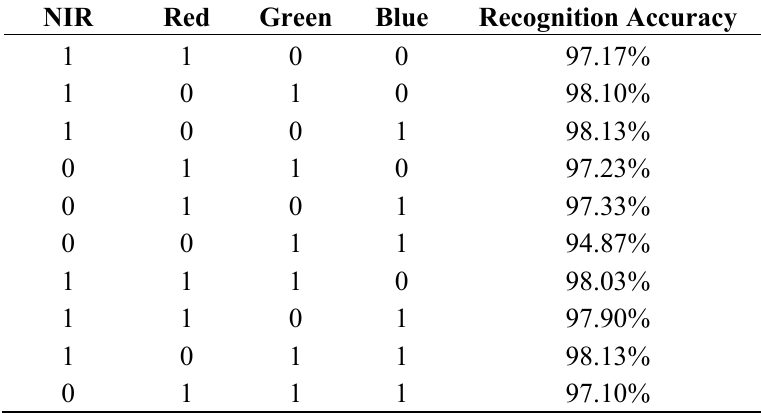
Table 2. Recognition accuracy of different situations using